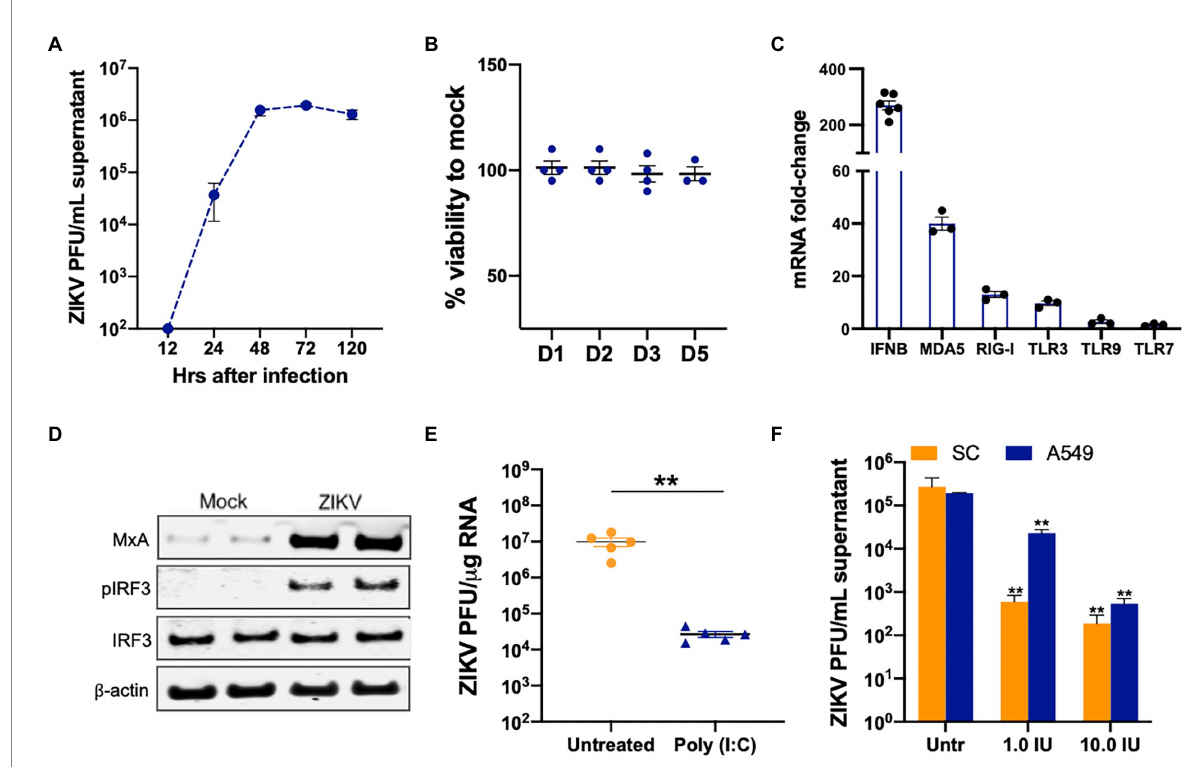
FIGURE 1 Viral RNA-sensing and type I IFN-associated pathways are functional in SC. (A) SC were infected with ZIKV at MOI 1 and ZIKV titers in the supernatant were measured at different time points using plaque assay and expressed as PFU/mL supernatant. (B) Cell viability was evaluated in infected SC at different days after infection using CellTiter 96 AQueous One Solution kit and shown as percent cell viability compared to mock- infected cells. (C) SC were infected with ZIKV at MOI 1 and gene expression of IFN- β , MDA5 , RIG-I , TLR3 , TLR7 , and TLR9 were measured using qRT-PCR at 48 h post-infection (hpi). The fold change was calculated as compared to mock-infected cells and normalized to GAPDH . (D) Whole- cell extracts from mock and infected SC at 48 hpi were subjected to Western blotting and stained for IRF3, p-IRF3, and MXA. The β -actin was used as a housekeeping loading control and each lane represents an independent experiment. (E) SC were pretreated with poly (I:C) 24 h before infection at MOI 1 and ZIKV RNA copies were determined at 48 hpi by qRT-PCR and expressed as ZIKV PFU equivalents per μ g RNA. (F) SC and A549 cells were pretreated with exogenous IFN- β at two concentrations 24 h before infection and ZIKV titers in the supernatant were measured at 48 hpi using plaque assay and expressed as PFU/mL. Data is presented as mean ± SEM from at least 3 to 5 independent experiments. ** p < 0.01 between respective IFN- β treated and untreated